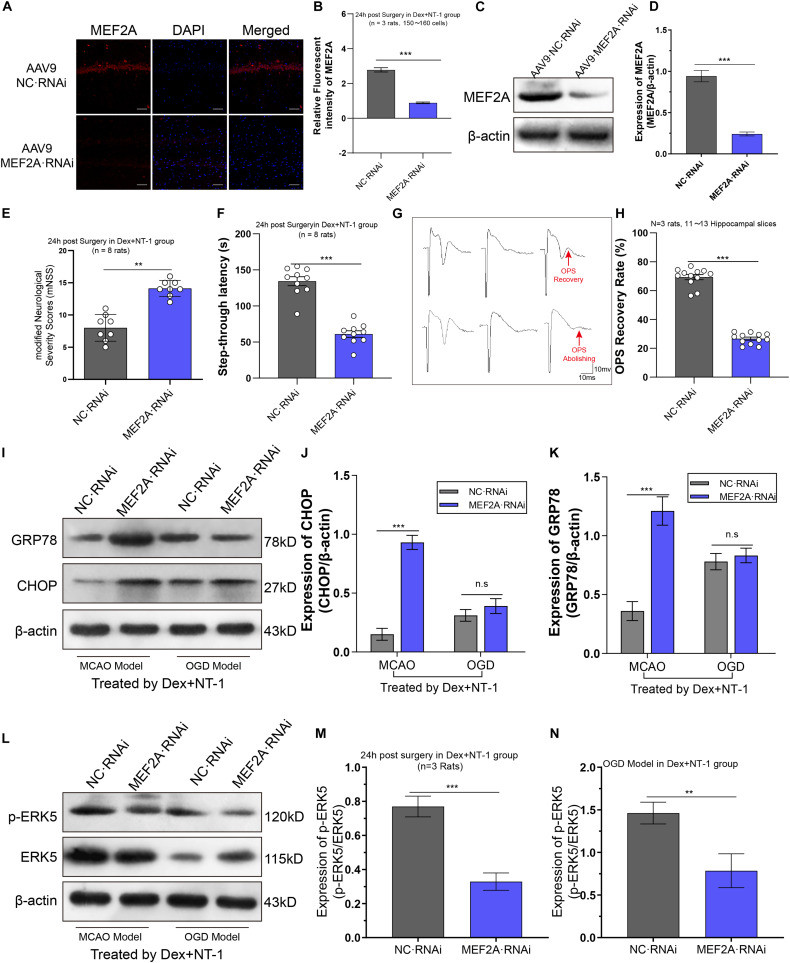
Knockdown MEF2A weakened the therapeutic effect of dexmedetomidine combined with Netrin-1 after MCAO and OGD injuries. (A,B) Immunofluorescence staining exhibited downregulation in MEF2A expression in the hippocampus at 14 days after AAV9-MEF2A RNAi microinjection. (C,D) Western blot analysis shows downregulation in MEF2A expression in the hippocampus at 14 days after AAV9-MEF2A RNAi microinjection. (E) The mNSS result after MEF2A knockdown. (F) The step-through latency result after MEF2A knockdown. (G,H) The OPS recovery rate after MEF2A knockdown. (I–K) Western blot analysis of ERS-related proteins CHOP and GRP78 in the hippocampus at 14 days after AAV9-MEF2A RNAi microinjection, β-actin was used as an internal control. (L–N) Western blot analysis of ERS-related proteins ERK5 and p-ERK5 in the hippocampus at 14 days after AAV9-MEF2A RNAi microinjection, β-actin was used as an internal control. ∗∗P < 0.01 and ∗∗∗P < 0.001 using one-way ANOVA followed by Tukey’s post hoc tests.